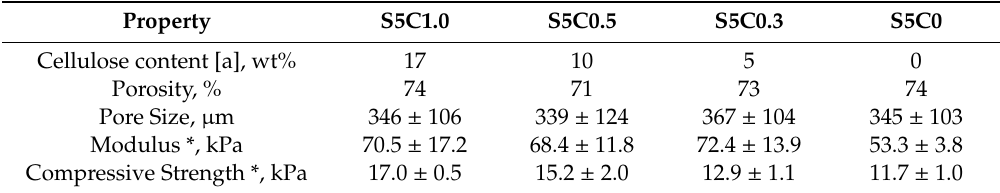
Table 2. Porosity, pore size, and compression properties of hydrogels.